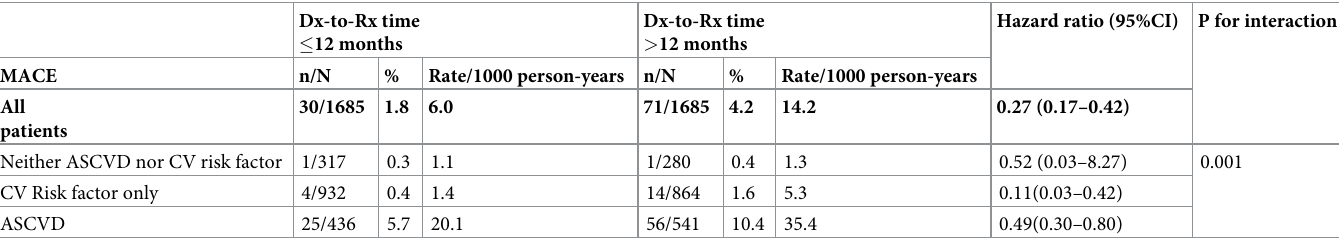
Table 2. MACE with Dx-to-Rx time � 12 months versus > 12 months in subgroups stratified by presence or absence of known ASCVD or risk